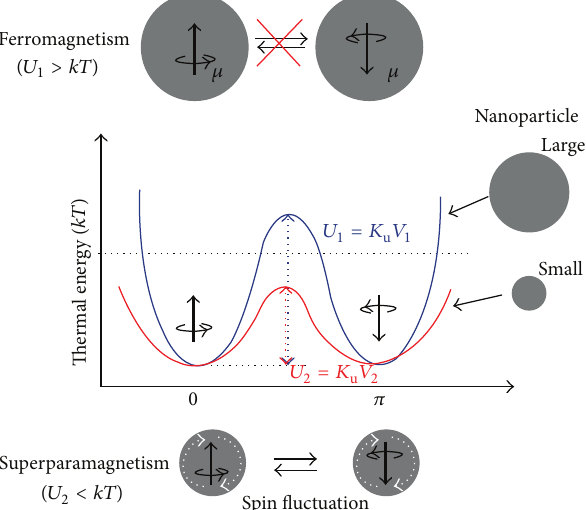
Figure 7: The variation of thermal and anisotropy energies by particles resizing from large scale (ferromagnetic structure) to fine nanoscale (superparamagnetic structure)